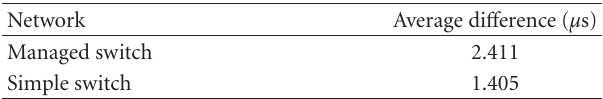
Table 10: Broadcast time di ff erence, in microseconds, for di ff erent networking